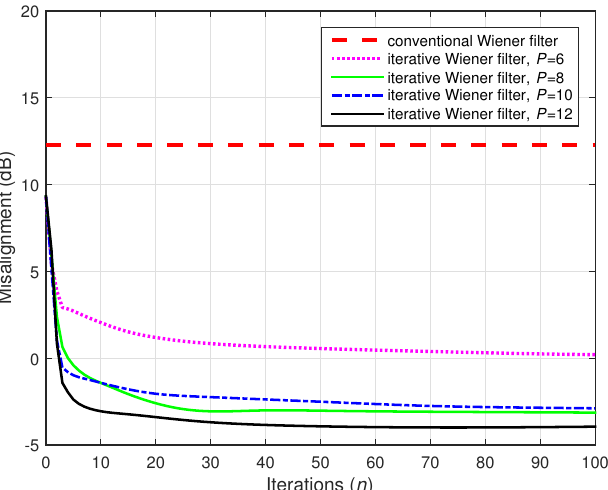
Figure 25. Performances of the conventional and iterative Wiener filters, using N = 2500. The source signal (white Gaussian noise) was preprocessed with positive and negative half-wave rectifiers, using α = 0.1. The numbers of channels were M = 2 (stereophonic scenario), L = 1024, and SNR = 30 dB.